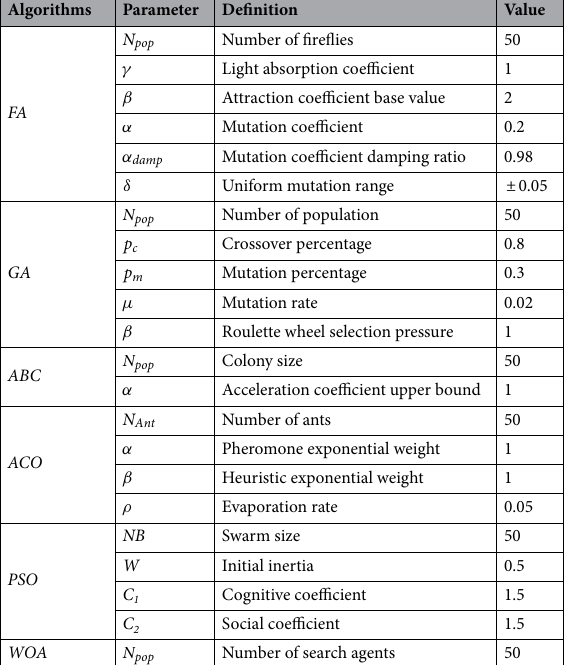
Table 2. Parameter presentation of the alternative metaheuristic